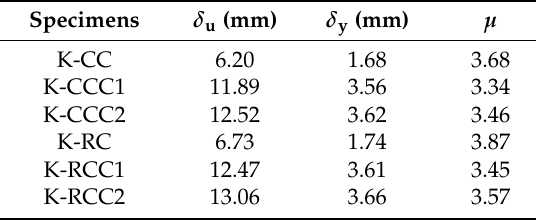
Table 3. Ductility coefficient of joints.